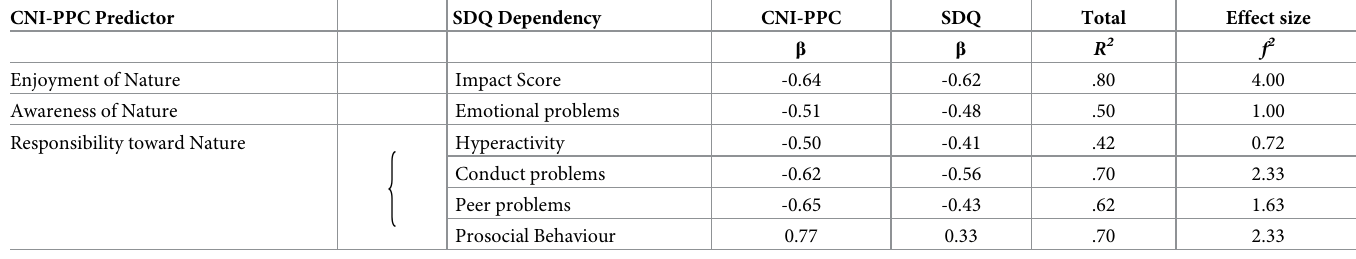
Table 4. Statistically significant paths from CNI-PPC to